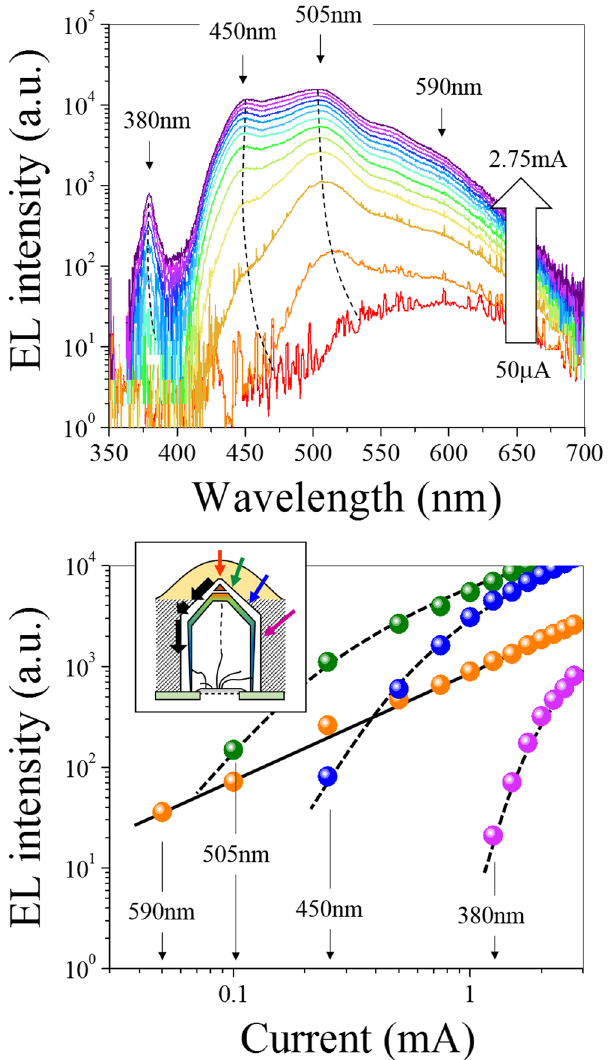
the CIE xy color coordinates of the EL spectra and plotted them in the chromaticity diagram (inset in Fig. 6). Depending on the carrier injection, the LED emits from deep orange to blue, covering the visible range. However, the colors are poorly saturated with a chromaticity of about 50, 40, and 68% for the blue, green, and orange colors, respectively. Such color saturation is not yet suitable for display applications, which require highly saturated pri- mary colors (represented by the white dots in the chromaticity diagram of the Fig. 6). An interesting approach to solve this problem would be to control the NRs geometry by tuning locally the selective area pattern size